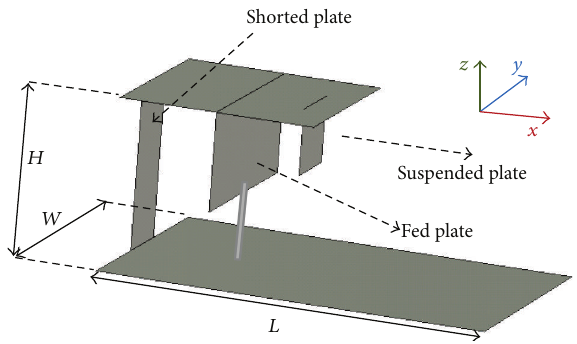
Figure 3: A PIFA consisting of a planar rectangular monopole top- loaded with a rectangular patch attached to two rectangular plates, one is shorted to the ground and the other is suspended [13].